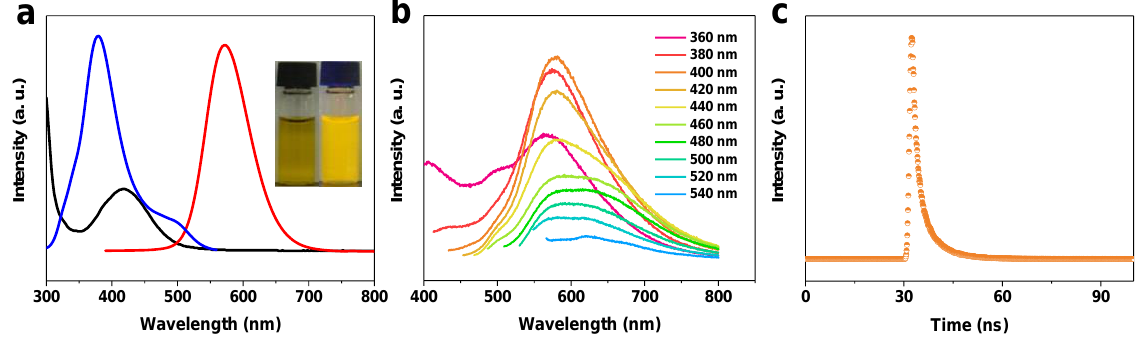
Figure 2. ( a ) The UV-vis, PL, and PLE spectra, ( b ) the PL spectra at different excitation wavelengths, and ( c ) the time-resolved PL spectrum of N-CDs.